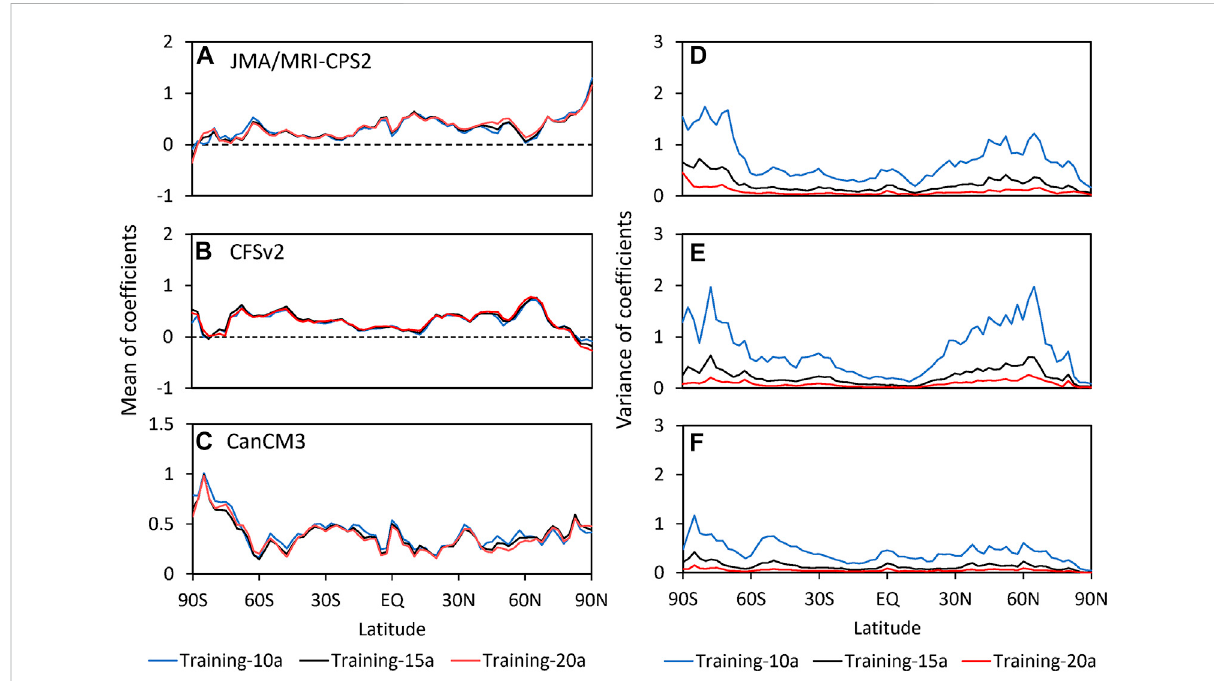
FIGURE 10 The zonal mean of regression coef fi cients of JMA/MRI-CPS2 (A,D) , CFSv2 (B,E) and CanCM3 (C,F) which obtained in the different training periods for the ensemble with partial regression of temperature in JJA season for the period 1982 – 2011: the multi-year average (left panel) and the variance (right panel) of regression coef fi